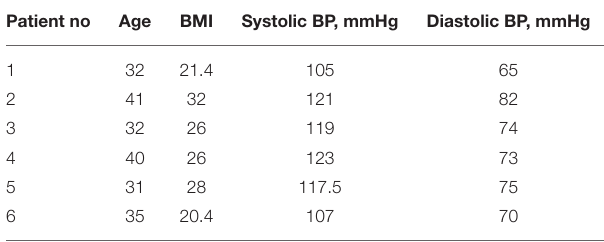
TABLE 1 | Demographic characteristics of the study